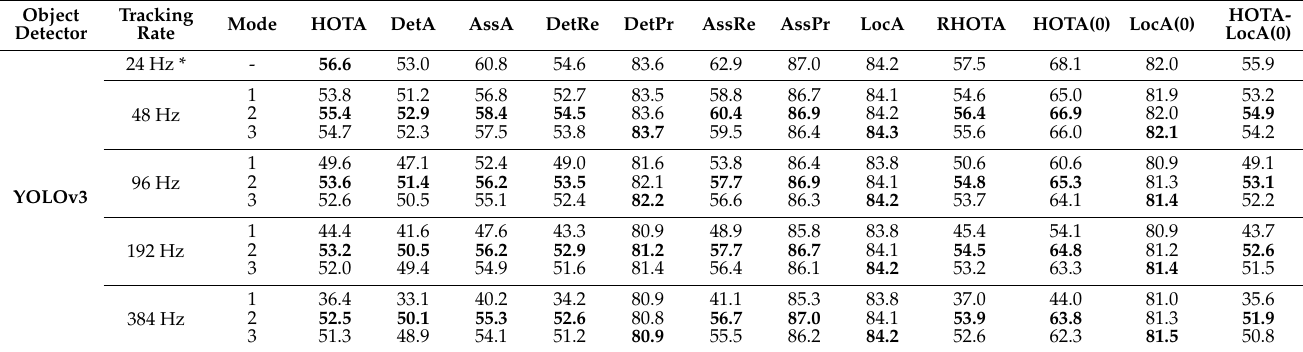
Table 2. Hybrid object detection and tracking results using HOTA metrics at different temporal resolutions, using the frame-based object detector YOLOv3. The results are shown for the three different event-based, inter-frame, tracking modes described in Section 3. Our approaches represented by modes 2 and 3 show significant promise regarding the ability to leverage event data to generate accurate high-temporal-resolution tracking results. The best metric value at each rate is in